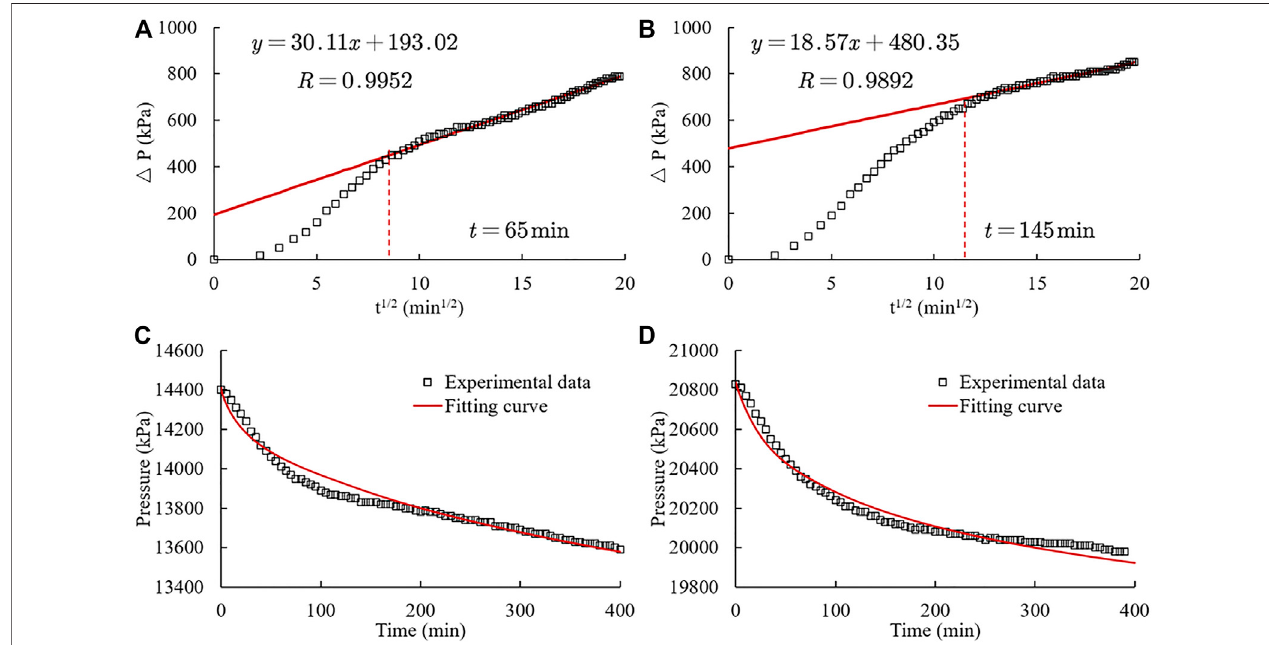
FIGURE 4 | Linear fi tting result of pressure drop and t 1/2 of Test 1 (A) and Test 2 (B) ; Best history fi tting curves of Test 1 (C) and Test 2 (D) .